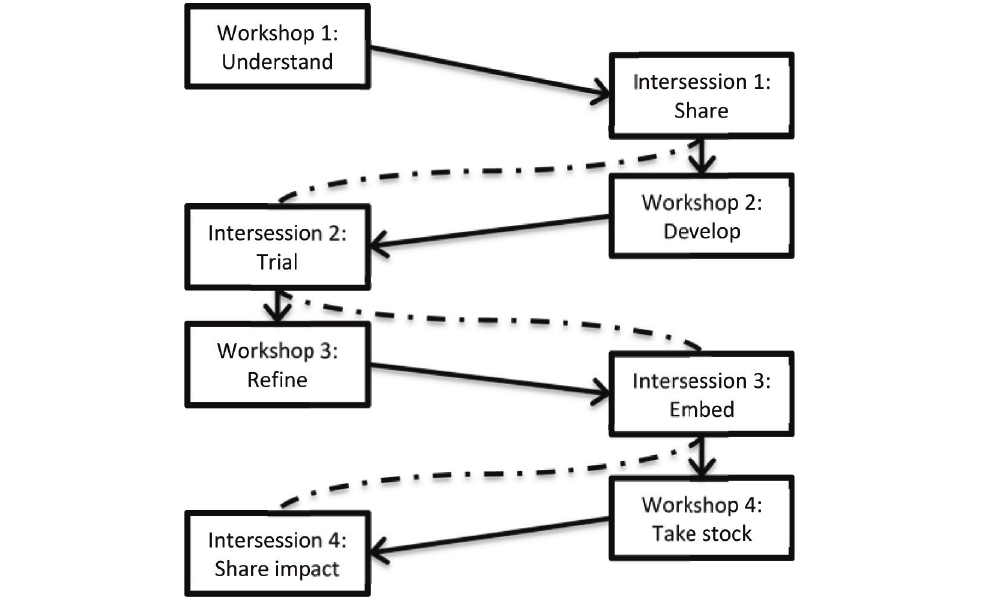
Figure 1: Structure of the four-workshop approach